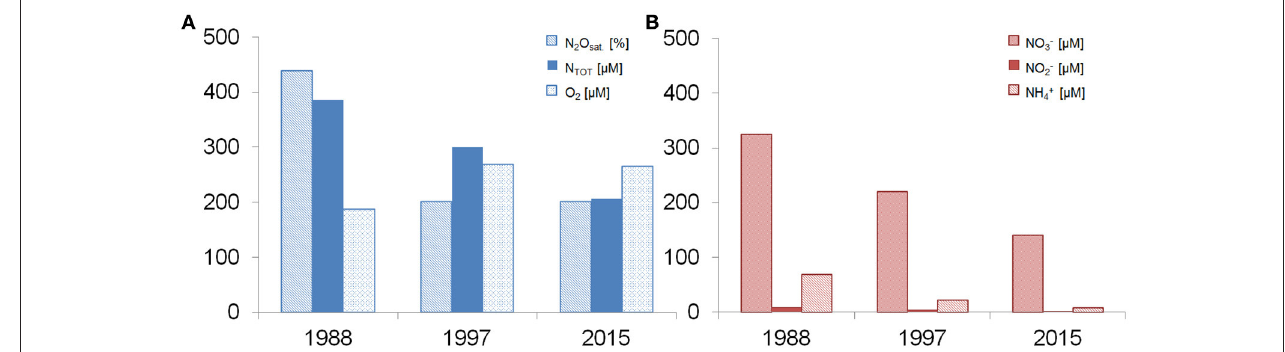
FIGURE 6 | Comparison of Elbe transect measurements for the years 1988, 1997, and 2015. (A) Average N 2 O saturation, and annual average total N and O 2 concentrations. (B) Annual average concentrations of dissolved NO − 3 , NO − 2 , and NH + 4 . Nutrient and O 2 data are available at: http://www.elbe-datenportal.de/